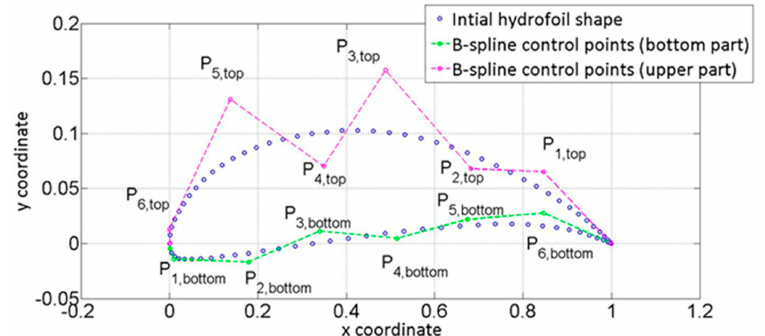
Figure 2. Decision variables for hydrofoil shape optimization (control points).